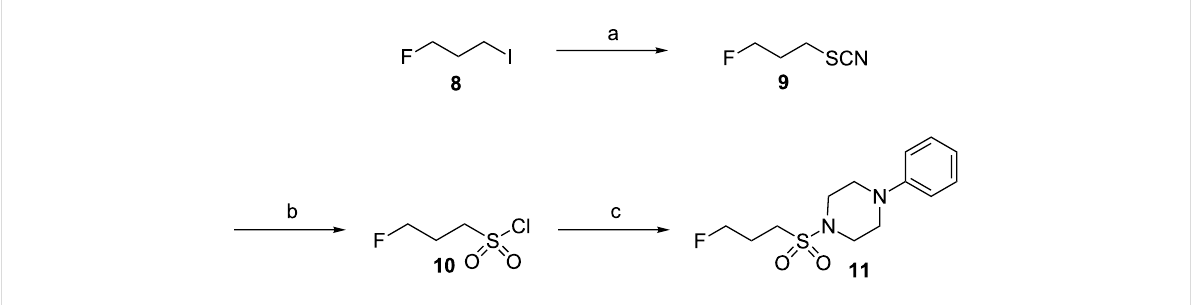
Scheme 2: Synthesis of 3-fluoropropanesulfonamide 11 via intermediary 3-fluoropropanesulfonyl chloride ( 10 ). Reagents and conditions: (a) KSCN, CH